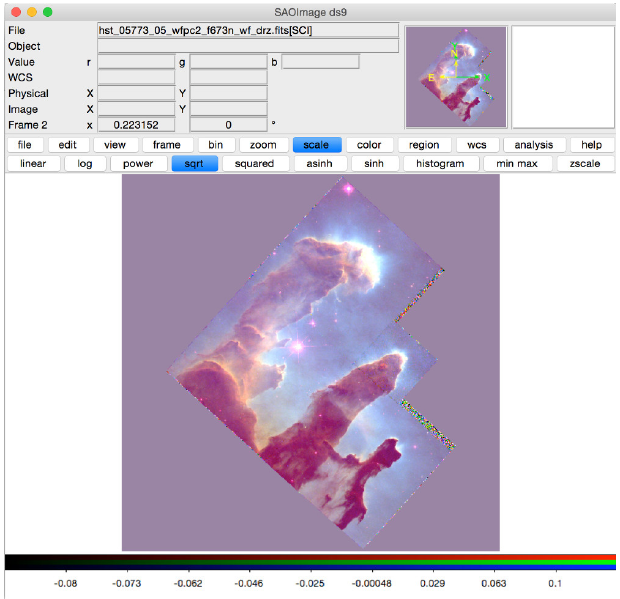
Fig. 41.— Colour image of the “pillars of creation” with DS9 media have had significant extra work applied to them, up to and including a person going over the image region by region, removing remaining impurities by hand, and cleaning up the